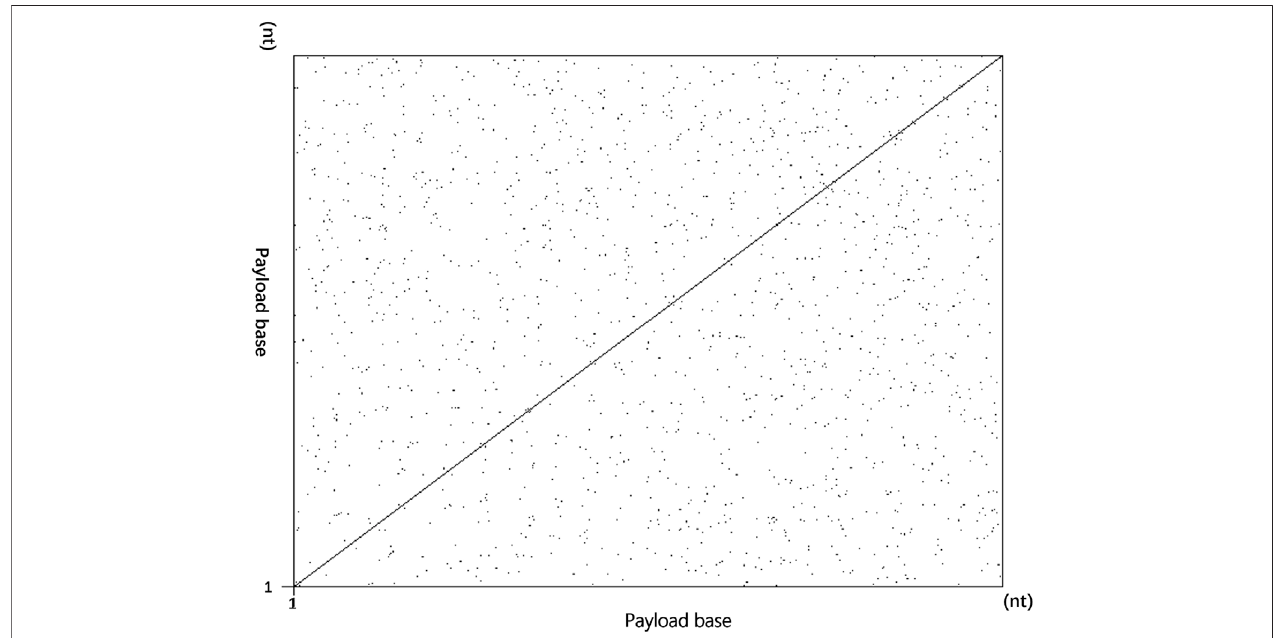
FIGURE 5 | Overall self-similarity generated dot plot of the encoded payload